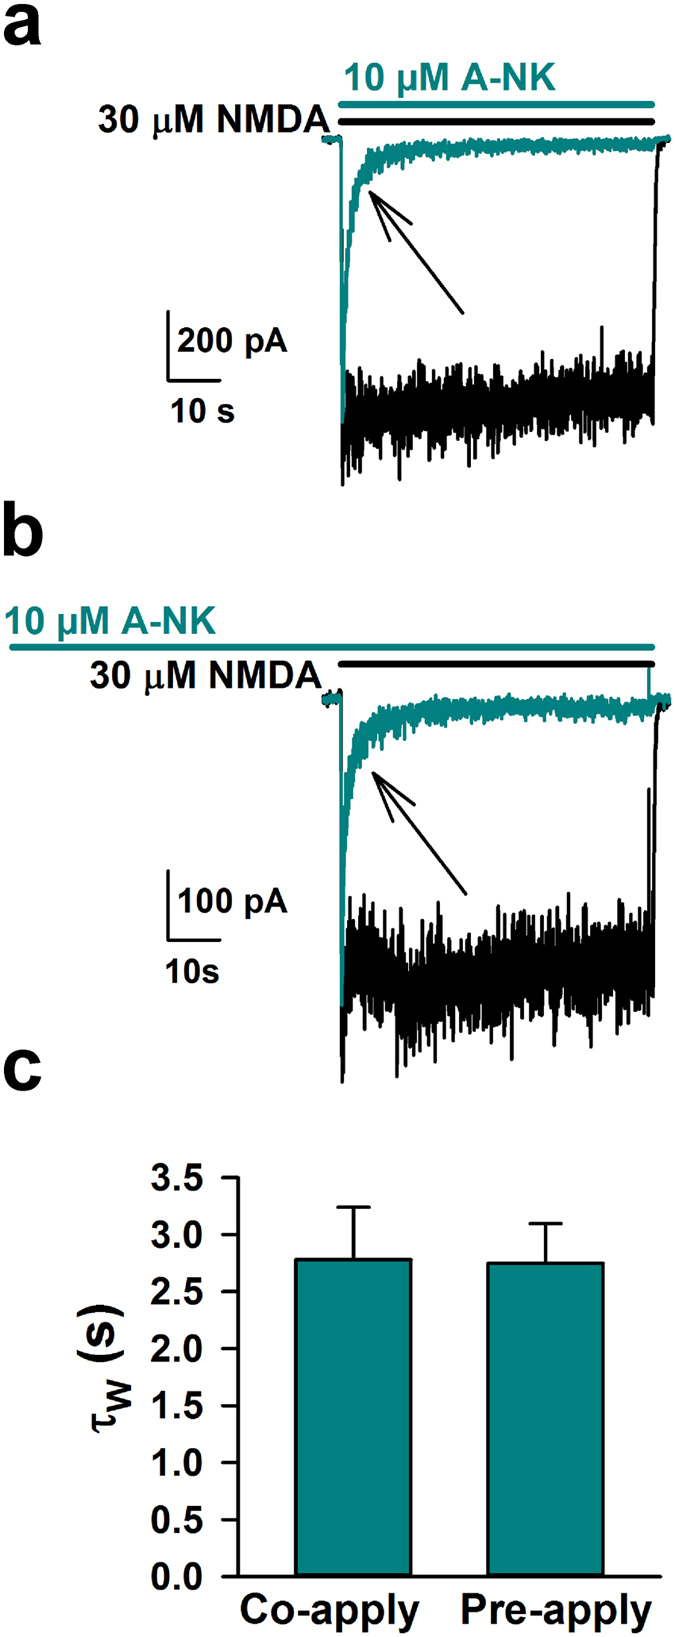
Pre-application of A-NK does not speed rate of block.(a) Representative trace of control current (black) in response to 30 μM NMDA or of current following a saline pre-application and immediate co-application of NMDA and 10 μM A-NK. (b) Same as in A, except prior to the cyan trace, A-NK was pre-applied for 60 seconds. (c) The rate of onset of block (depicted by arrows in a, b) was calculated for both protocols by fitting a bi-exponential function to the drug onset and calculating a weighted time constant (τw). There was no significant difference between blocking rates during the different pre-application protocols (n = 5 each, p > 0.05, unpaired t-test).